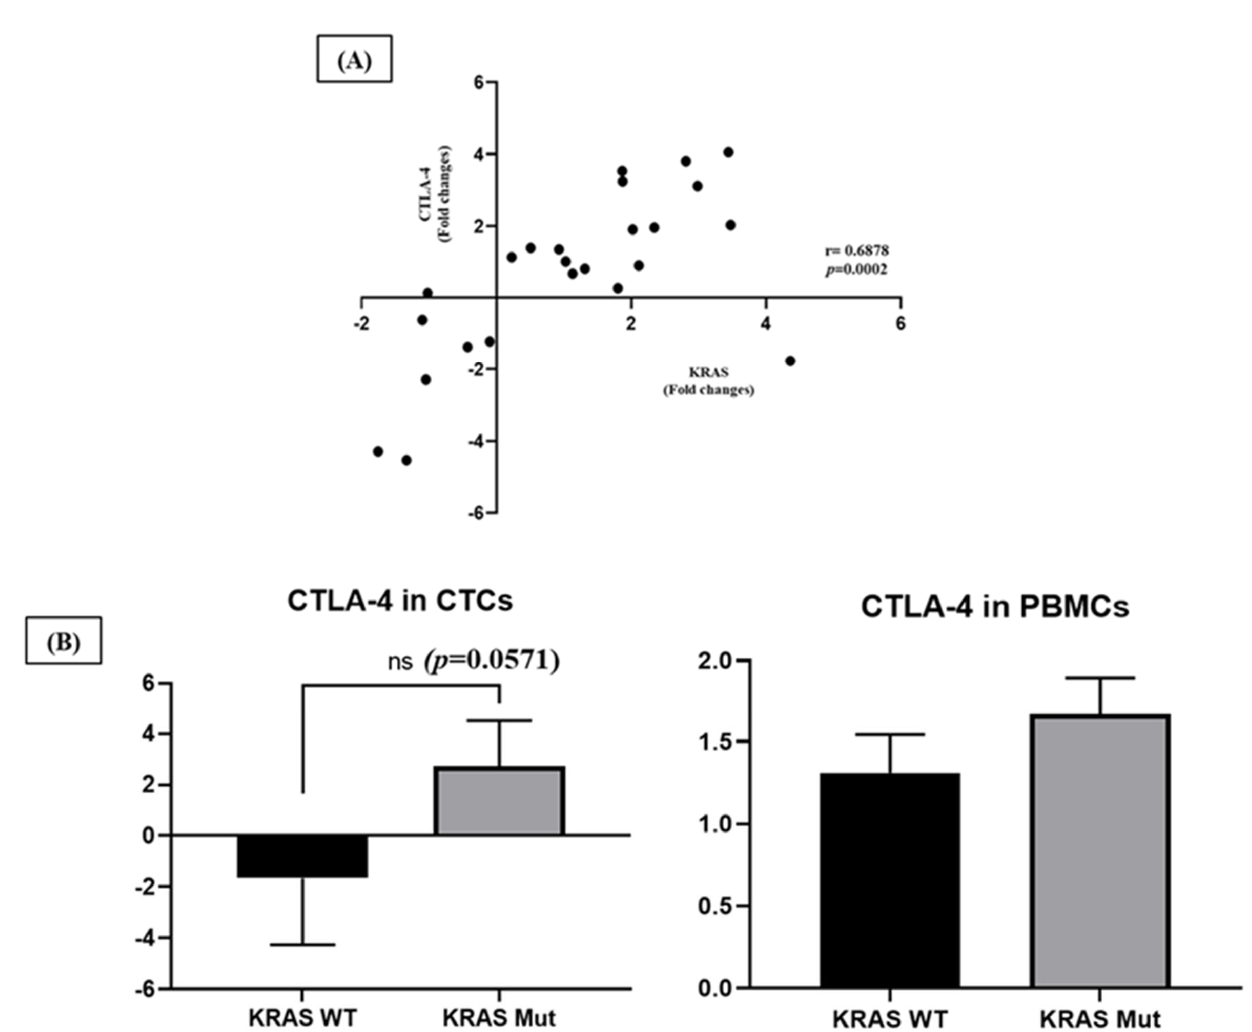
Figure 4. Correlation between KRAS gene and CTLA-4 expression in CTCs. ( A ) The mRNA expression level of CTLA-4 correlated positively with KRAS ( r = 0.6878, p = 0.0002). r; coefficient correlation value (Spearman’s rank test). ( B ) The mRNA expression levels of CTLA-4 in CTCs and PBMCs from patients with CRC according to the KRAS mutation status of the primary tumour.